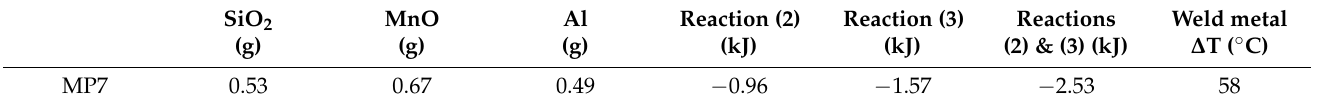
Table 6. Exothermic heat added to the weld pool from reactions (2) and